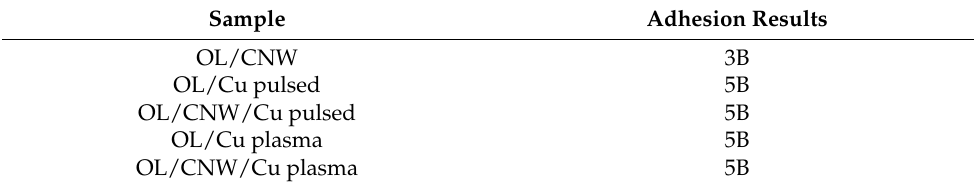
Table 1. Adhesion test